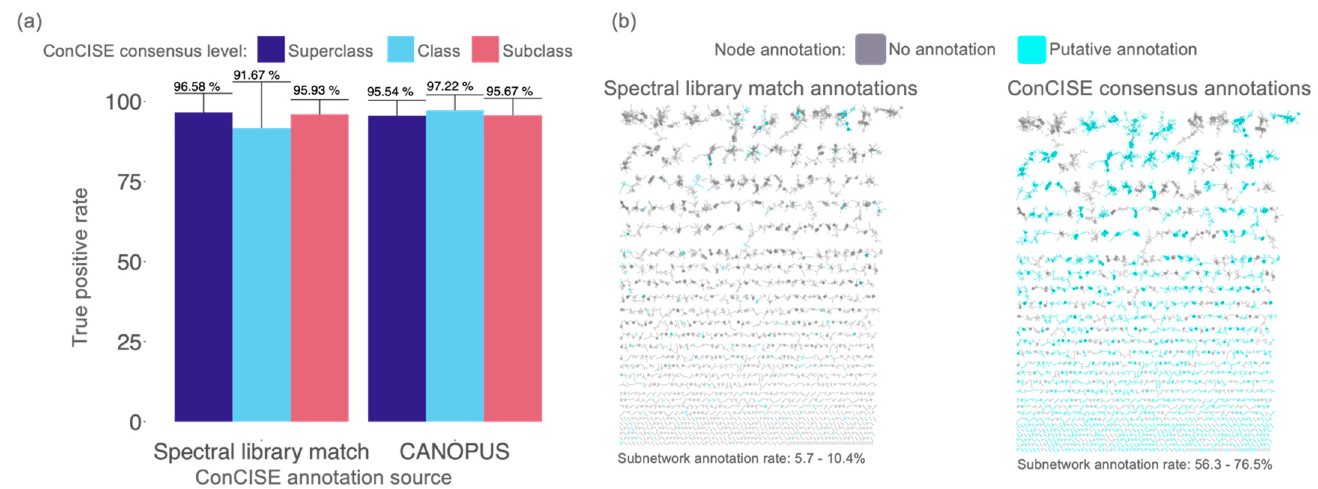
Figure 2. Manually verified true positive rate of ConCISE consensus annotations and increase in annotation rate. ( a ) True positive rate of each classification level in all three validation datasets. ( b ) Example network (MassIVE ID: MSV000082083) illustrating annotation rates from spectral library matches ( left ) and ConCISE ( right ) with putative annotations colored in light blue. Ranges in annotation rate were given for the three datasets used to verify ConCISE. Network annotation rates calculated without single-loop nodes.